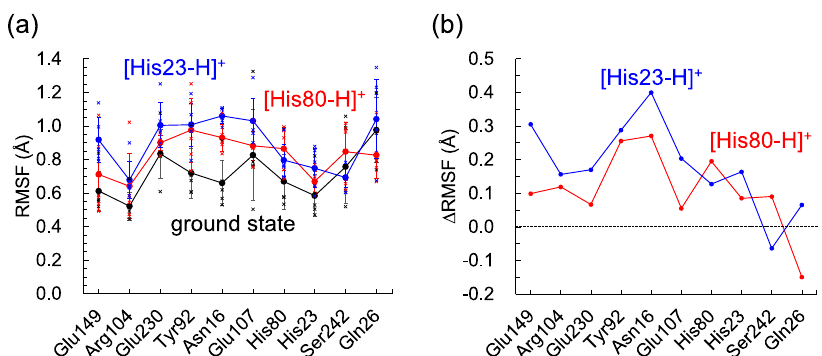
Fig. 7 His80/His23 protonation and the fl uctuation of the H-bond network. a Root mean square fl uctuation (RMSF) of the side-chains along the H-bond network of the Schiff base in the ground state (black line) and the M state with doubly protonated His80 (red line) and doubly protonated His23 (blue line) conformations in the range of 0 – 150 ns. Vertical bars represent standard deviations of fi ve independent MD runs. Crosses indicate RMSF values in each MD run for the ground state (black), the M state with doubly protonated His80 (red), and the M state with doubly protonated His23 (blue) conformations. b RMSF with respect to the ground state ( Δ RMSF). His23 and His80 are charge-neutral in the ground